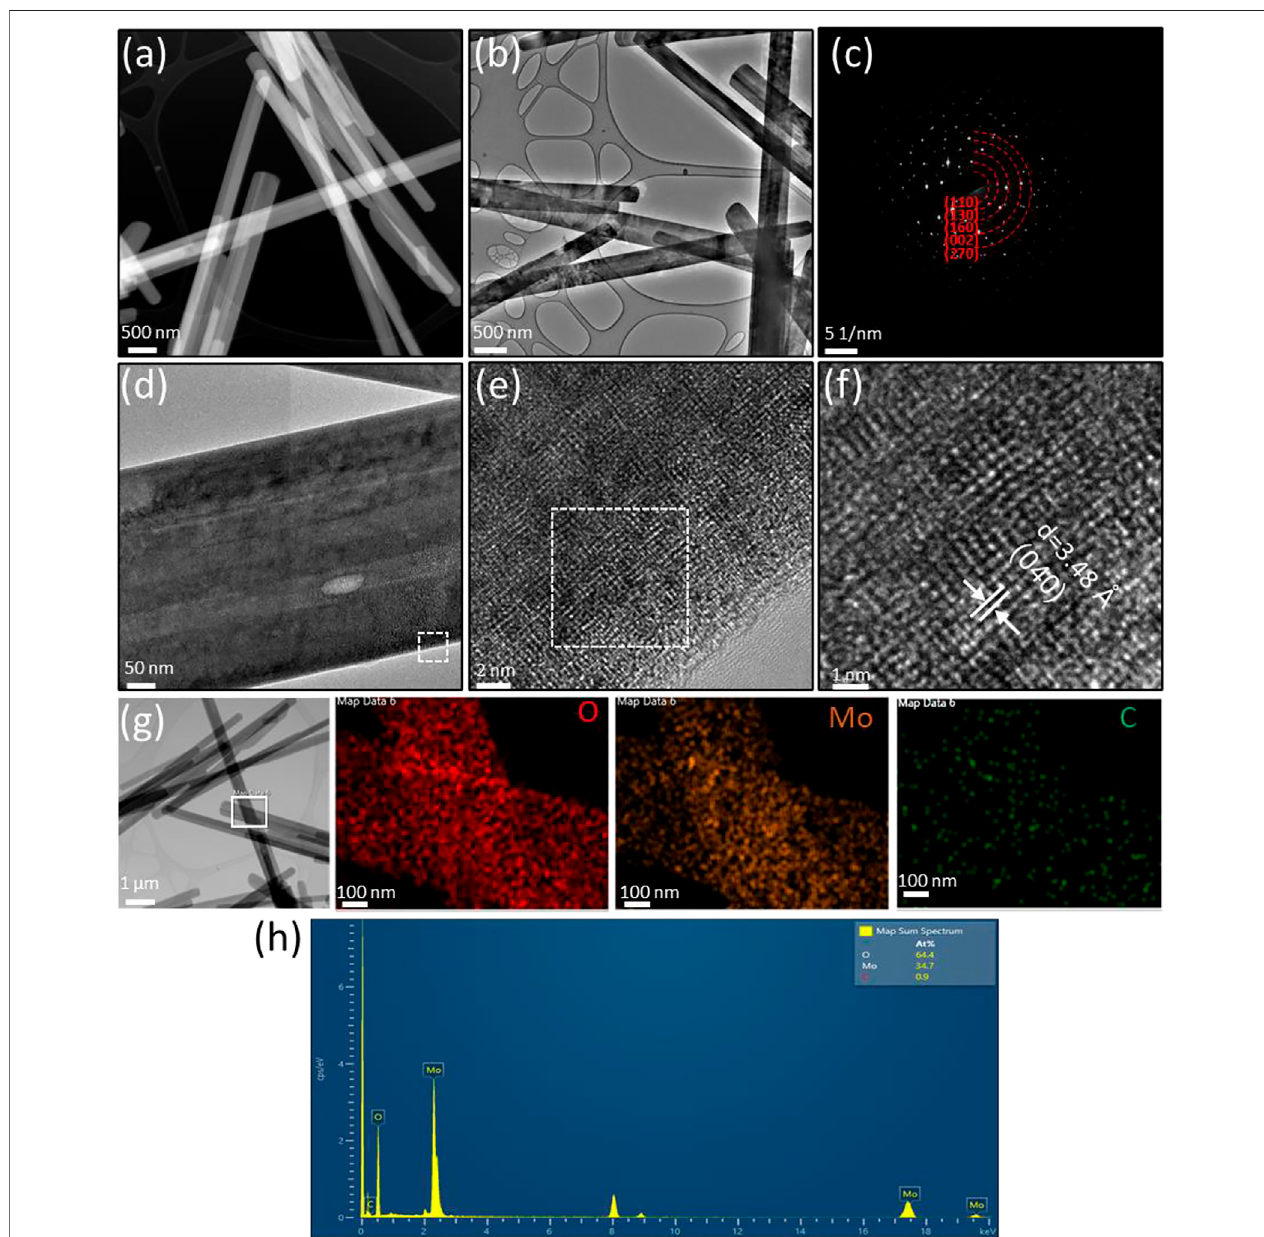
FIGURE4 | Structuralcharacterization of α -MoO 3 -ref. (A) HAADF-STEM image. (B) TEMimage. (C) SAEDpattern (D – F) HRTEM image of thearea marked by the white box in (D) . (G – H) TEM-EDS mapping and spectroscopy of the area marked by the white box in (G) .